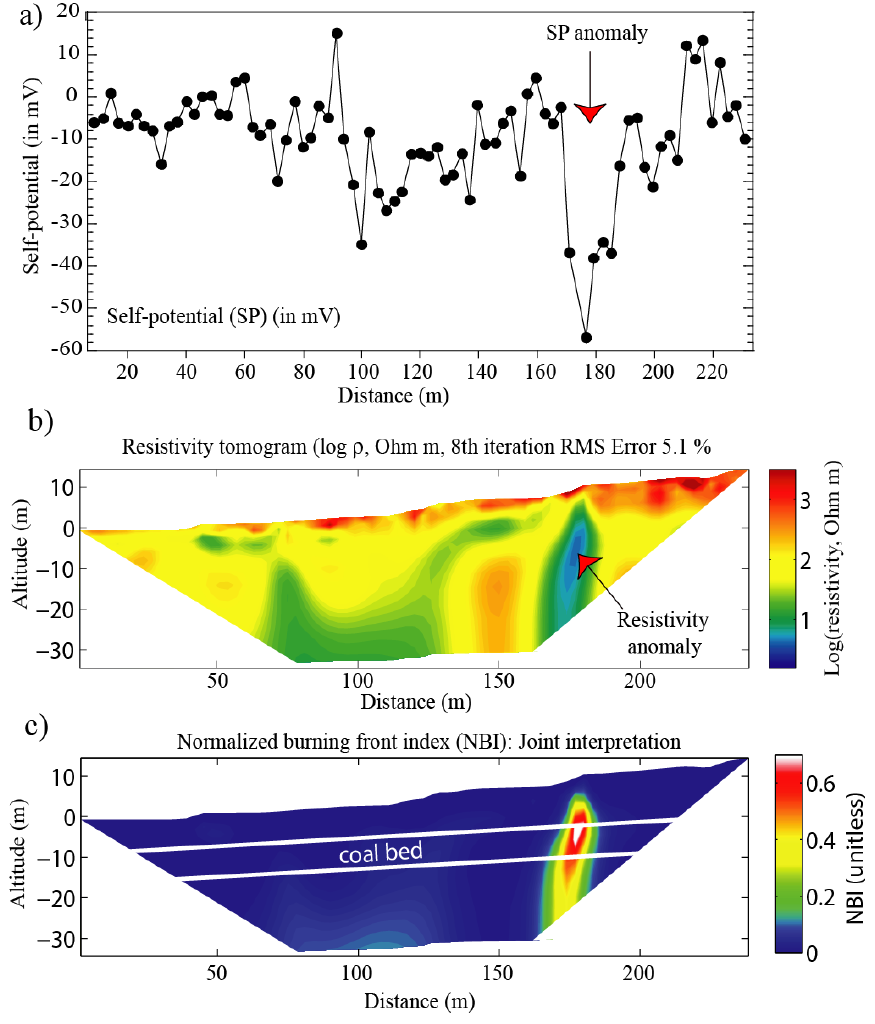
Figure 12. Self-potential (SP) and resistivity data. ( a ) Self-potential data (79 stations performed at the ground surface) showing a self-potential anomaly at about 175 mV over the burning area; ( b ) Electrical resistivity tomogram (714 apparent resistivity data, Wenner-α, 79 electrodes, inverted with a Gauss-Newton algorithm with isotropic smoothing). Note the low resistivity anomaly (2 Ω·m) at about 175 m below the negative self-potential anomaly (−50 mV); ( c ) Burning front index based on the self-potential and resistivity values. High values correspond to a high probability zone in terms of recovering the position of the burning front. The depth of the maximum of the NBI coincides with the depth of the coal bed (approximately 10 m) (modified after